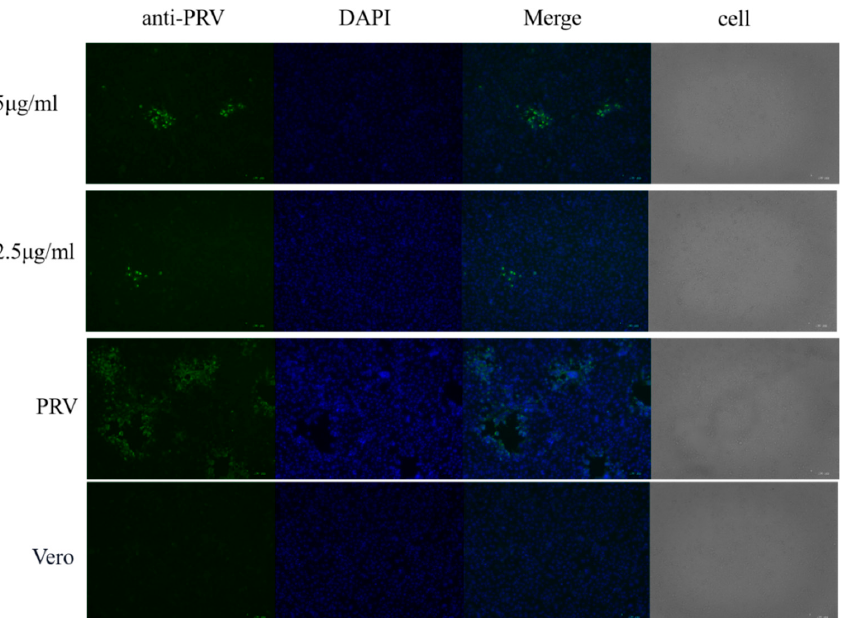
Figure 6. Indirect immunofluorescence assay of compound 2. Vero cells were infected with 100 TCID 50 PRV for 1.5 h, and then compound 4 (5 and 2.5 μ g/mL) was added. After 24 h, the indirect immunofluorescence assay was used for virus detection. The nucleocapsid (DAPI, blue) and anti-PRV (Green) responses are shown.